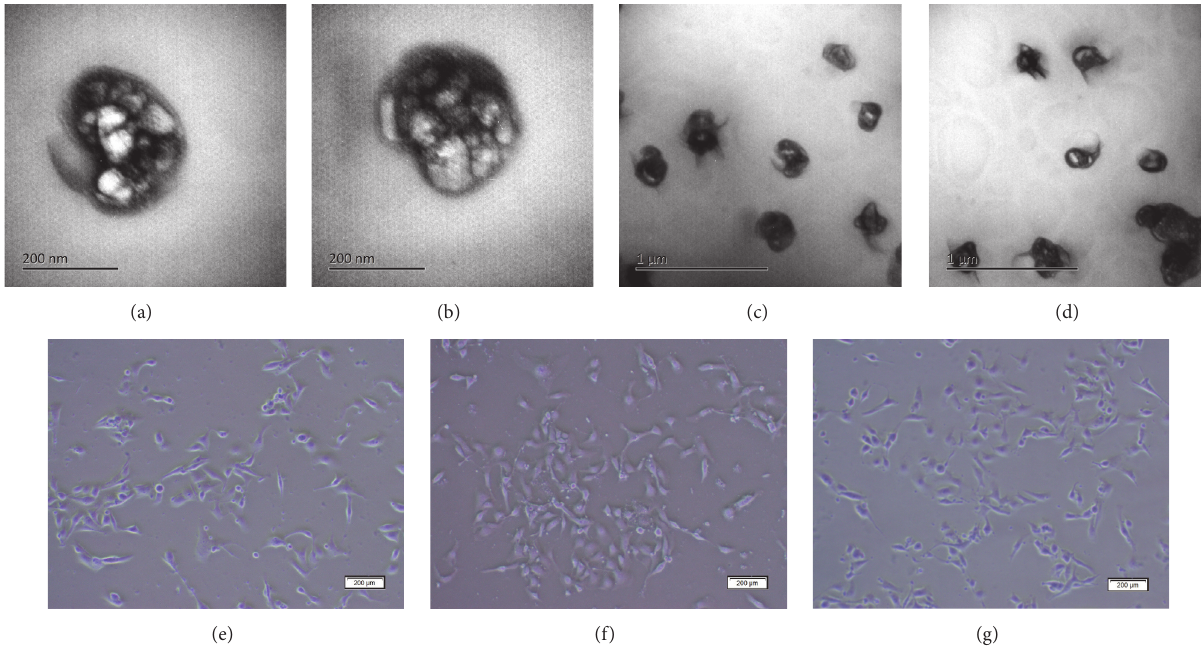
Figure 4: Characteristics of 2D-MSC-MVs and 3D-MSC-MVs. (a)–(d) By electron microscopy, both 2D-MSC-MVs (a, c) and 3D-MSC- MVs (b, d) displayed sizes ranging from 100 nm to 400 nm. Scale bar = 200nm, 1 um. (e)–(g) Light microscopy analyses showed that, similar to controls (e), both of 2D-MSC-MVs (f) and 3D-MSC-MVs (g) could maintain the normal shape of cocultured 661W cells (scale bar = 200